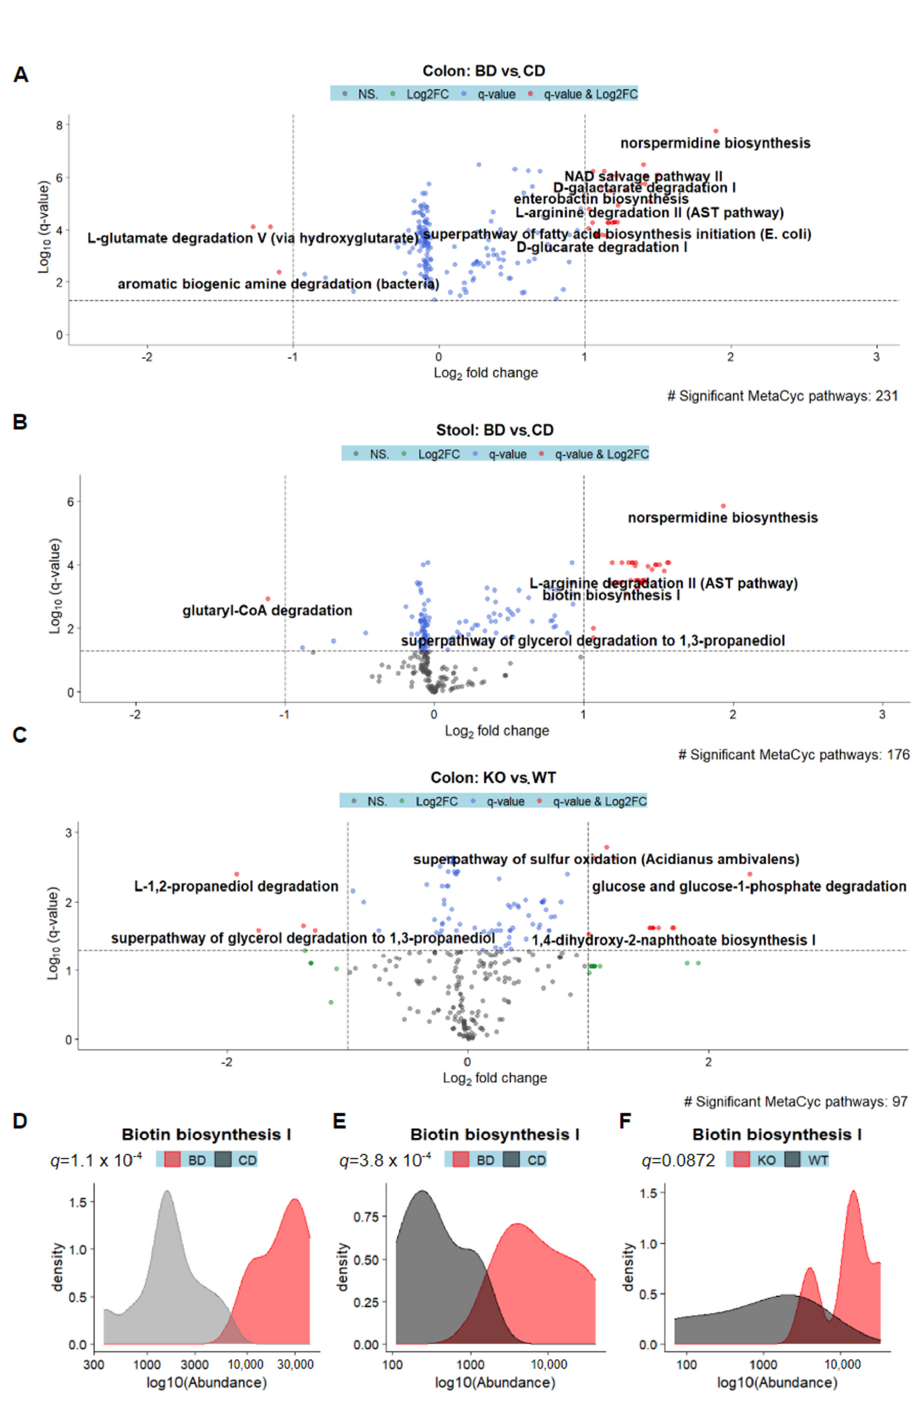
Figure 6. Predictive metagenomics of the dietary biotin deficiency and host biotin deficiency models reveal perturbed functional pathways and biotin biosynthesis. Volcano plots illustrating significantly differentially abundant Metacyc pathways which are associated with dietary biotin-deficiency (BD) in the colon ( A ) and stool ( B ) datasets or host BD in colon ( C ), with each dot representing a single pathway. Labels are not shown for all pathways. Density plots showing the log10-transformed predicted abundances of the Biotin biosynthesis I pathway in the colon ( D ) and stool ( E ) of dietary BD mice, or of the colon in host BD mice ( F